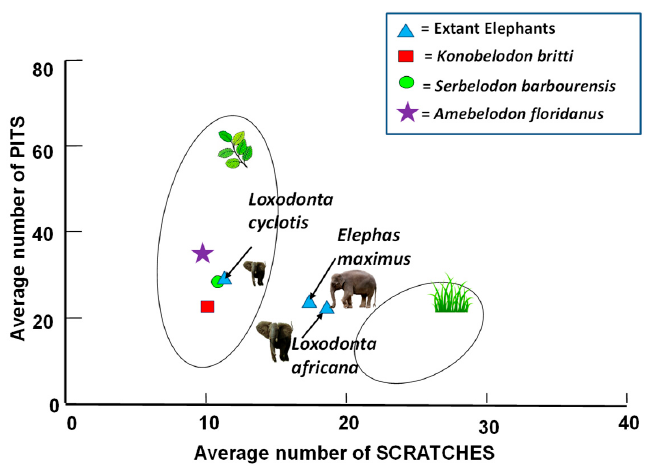
Figure 5. Fossil shovel-tusker average scratch/pit bivariate plots. Bivariate plot of the average number of pits versus the average number of scratches for the fossil and extant proboscideans analyzed graphed in relation to Gaussian confidence ellipses ( p = 0.95) on the centroid for extant ungulate browsers (left) and grazers (right) (convex hulls) adjusted by sample size (ungulate data from [24]; elephant data from [34] ) .